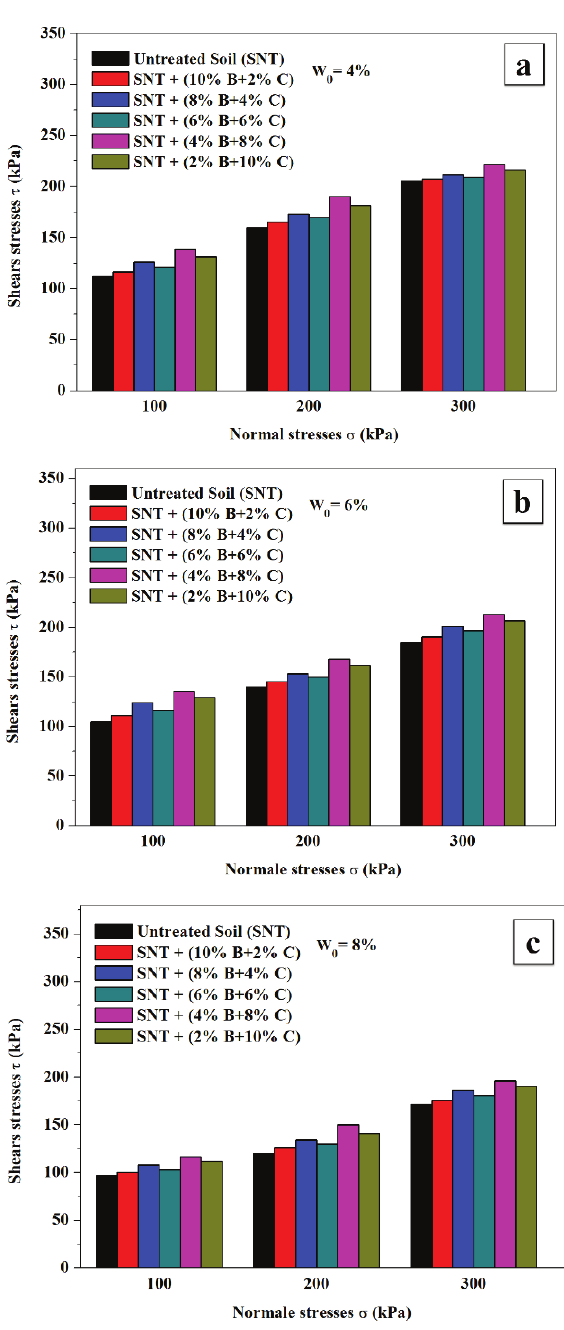
Figure 5: Variations of the tangential stresses of the various mixtures before and after treatment.